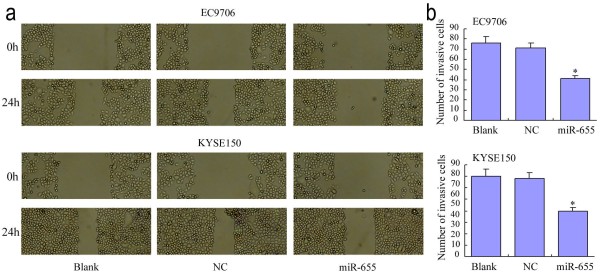
Overexpression of miR-655 increases cell migration and invasion ability. (a) Microscopic observations were recorded 24 hours after scratching the cell surface. The wound healing of miR-655 group was weaker than that of Blank and NC groups. (b) The number of invasive miR-655-transfected EC9706 and KYSE150 cells passing through the trans-well membrane were significantly lower than those in the Blank and NC groups (P < 0.05). Blank, non-transfected cells; NC, cells transfected with scrambled miR-655 negative control; miR-655, cells transfected with miR-655 mimics. *P < 0.05 compared to the control group.